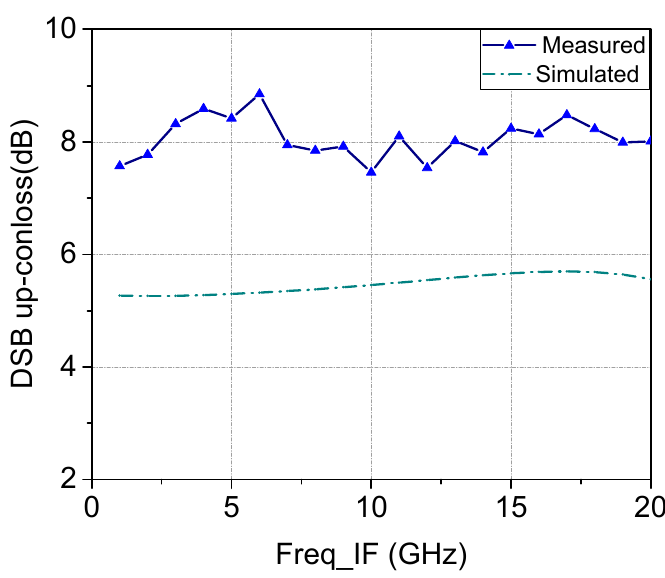
Figure 12. The up-conversion performance of the mixer. Table 1. Comprehensive comparison of the reported sub-harmonic mixer.